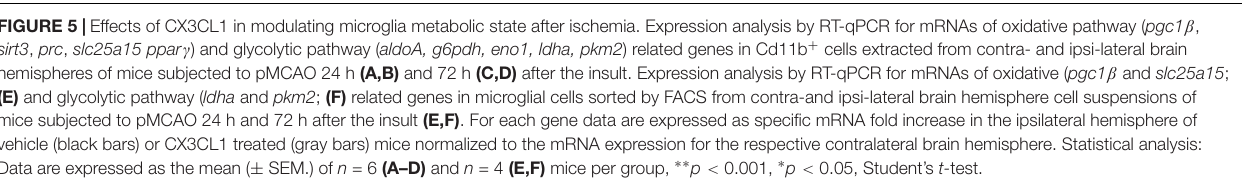
FIGURE 5 | Effects of CX3CL1 in modulating microglia metabolic state after ischemia. Expression analysis by RT-qPCR for mRNAs of oxidative pathway ( pgc1 β , sirt3 , prc , slc25a15 ppar γ ) and glycolytic pathway ( aldoA, g6pdh, eno1, ldha, pkm2 ) related genes in Cd11b + cells extracted from contra- and ipsi-lateral brain hemispheres of mice subjected to pMCAO 24 h (A,B) and 72 h (C,D) after the insult. Expression analysis by RT-qPCR for mRNAs of oxidative ( pgc1 β and slc25a15 ; (E) and glycolytic pathway ( ldha and pkm2 ; (F) related genes in microglial cells sorted by FACS from contra-and ipsi-lateral brain hemisphere cell suspensions of mice subjected to pMCAO 24 h and 72 h after the insult (E,F) . For each gene data are expressed as specific mRNA fold increase in the ipsilateral hemisphere of vehicle (black bars) or CX3CL1 treated (gray bars) mice normalized to the mRNA expression for the respective contralateral brain hemisphere. Statistical analysis: Data are expressed as the mean ( ± SEM.) of n = 6 (A–D) and n = 4 (E,F) mice per group, ∗∗ p < 0.001, ∗ p < 0.05, Student’s t-